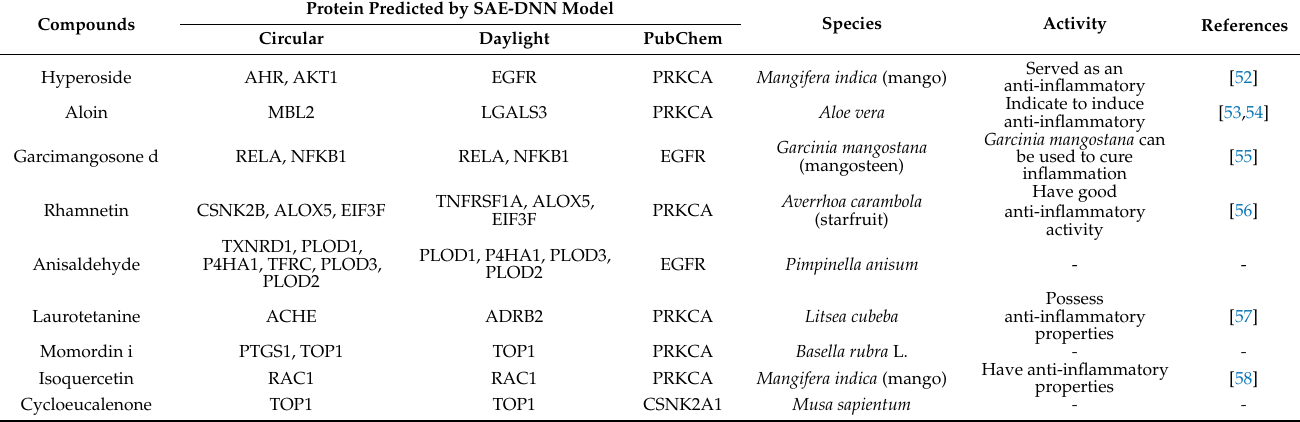
Table 7. The details of the compounds that appear in the prediction results of the three SAE-DNN models. Protein Predicted by SAE-DNN Compounds